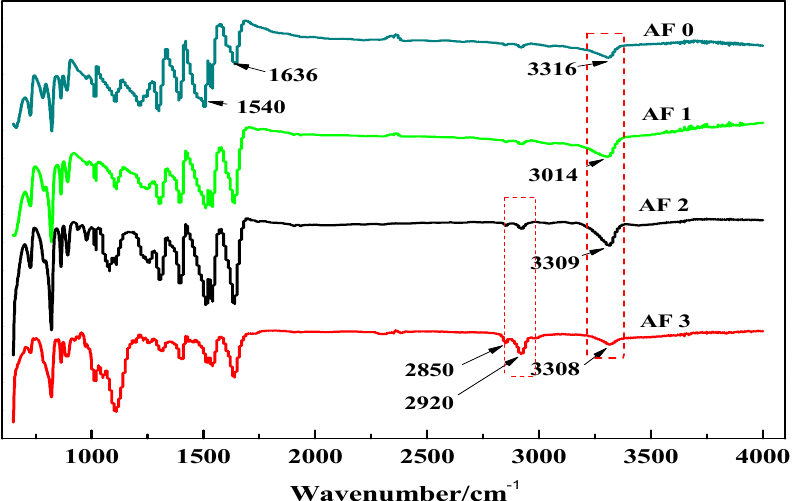
Figure 5. FT-IR spectra of aramid fiber before and after treatment.